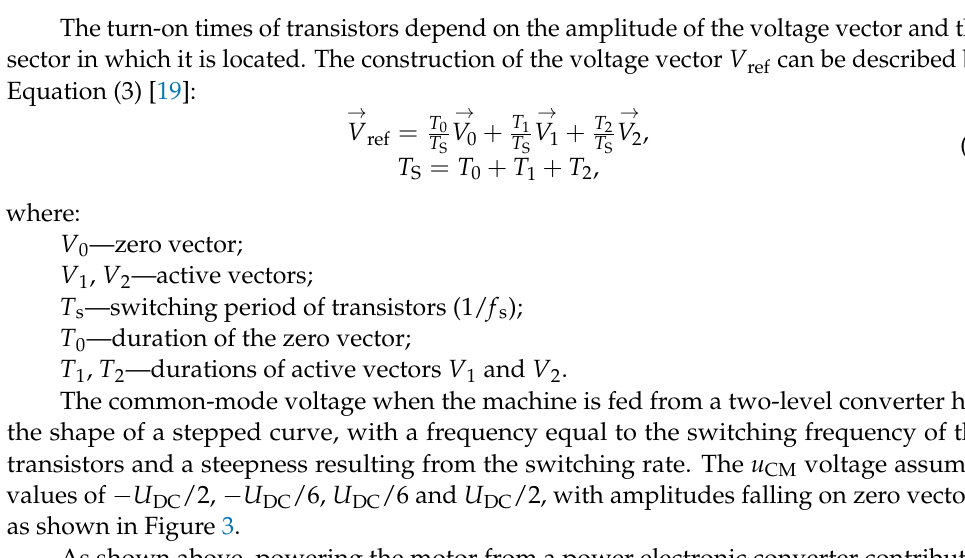
Figure 3. Examples of waveforms of phase voltages at the output terminals of a two-level DC/AC converter and the common-mode voltage u CM .